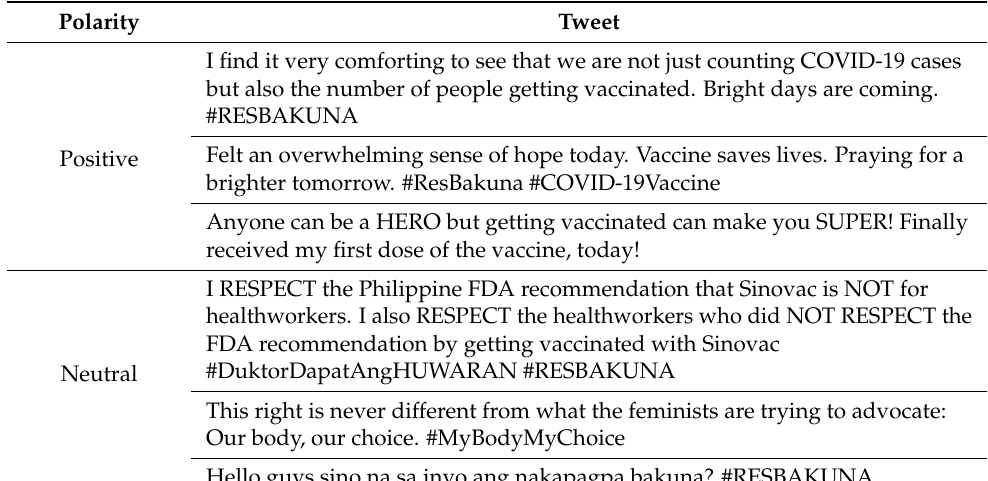
Table 4. Some examples of tweets with positive, neutral, and negative polarities that were annotated by hand and imported as a dataset in RM for data processing, model training, and